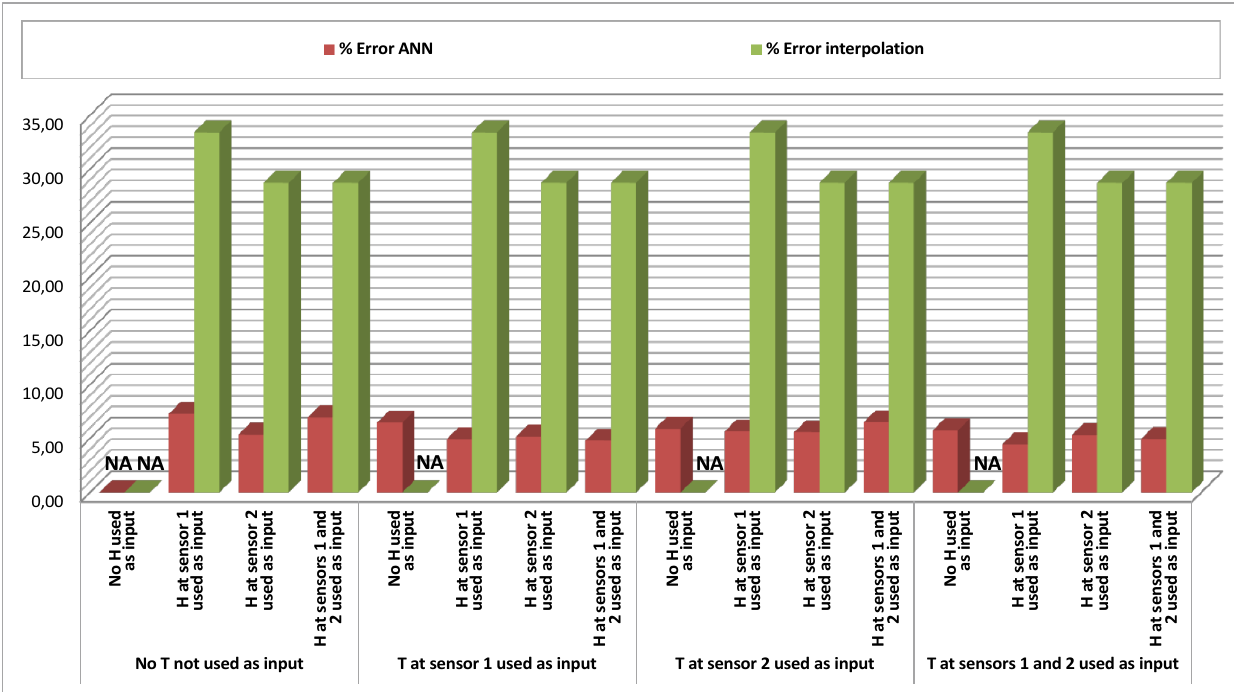
Figure 5. Data Estimation results (% error ANN/% error interpolation) for Humidity (H) in Sensor 3 (S3), combining Temperature (T) and Humidity (H) in Sensors 1 and 2 (S1 and S2) as